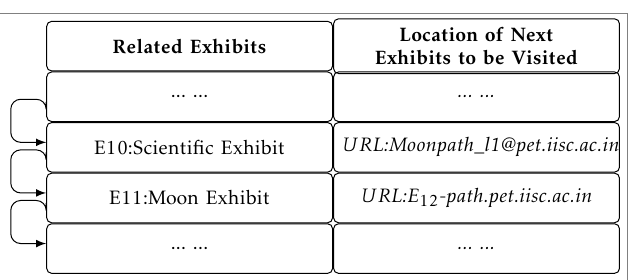
Figure 8. CC and ECR Formation Time for Museum Ubiquitous Visitors